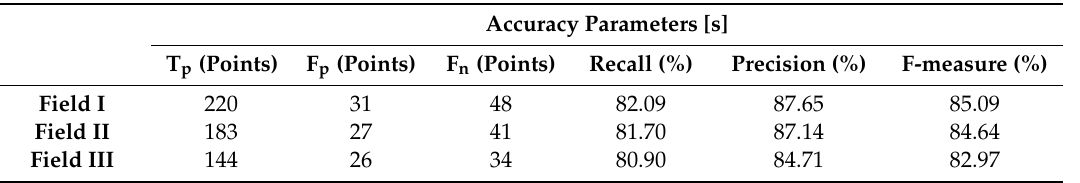
Table 7. Real-time field evaluation results of developed machine vision